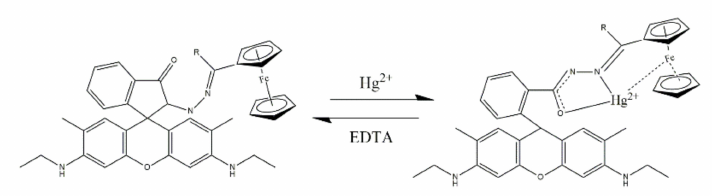
Figure 7. The proposed sensing mechanism of the prepared probe (Table 1, No. 8) to Hg 2+